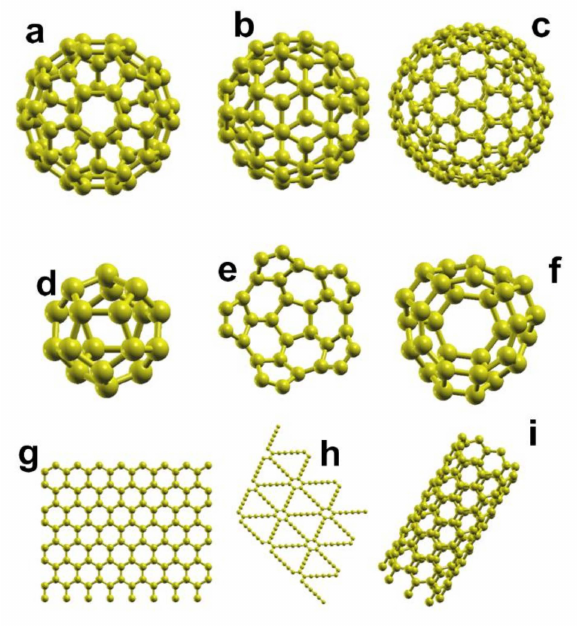
Figure 1. These are some of the carbon nanostructures reported experimentally. In ( a , b ), we have C 60 ; we present the C 180 in ( c ); C 20 in ( d ); the buckybowl C 30 in ( e , f ); graphene in ( g ); graphdiyne in ( h ); a single-walled carbon nanotube (SWCNT) in ( i